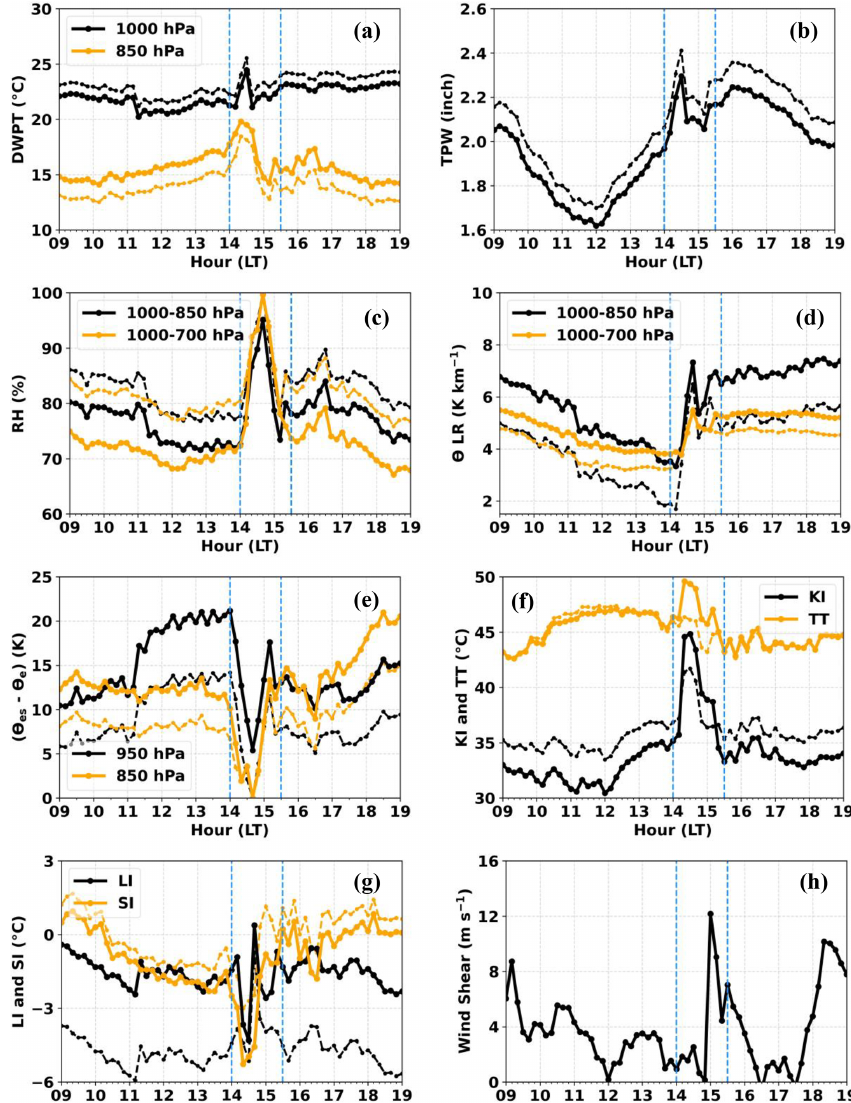
Figure 13. Original (light color) and corrected (bold color) MWR-derived (a) DWPT, (b) TPW, (c) mean RH, (d) θ LR, (e) ( θ es – θ e ), (f) KI and TT, (g) LI, and SI and DL-derived (h) wind shear (100m–1km) at Albany on 12 August 2021. The dotted box represents the thunderstorm